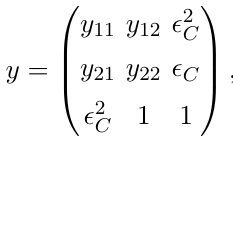
Figure 15 . Indicative plot of the allowed parameter space scans showing (cid:22) S leptoquark coupling matrix Texture B. The purple line indicates the current Br( (cid:22) ! e ) Au cut-o(cid:11), the dotted orange (yellow) line indicates the prospective cut-o(cid:11) from the Mu2e/COMET (PRISM) experiment. The light green region shows parameter space that is excluded by Br( (cid:22) ! e(cid:13) ). The orange region of the parameter space is constrained by Br( (cid:22) ! e ) Au , the teal region is